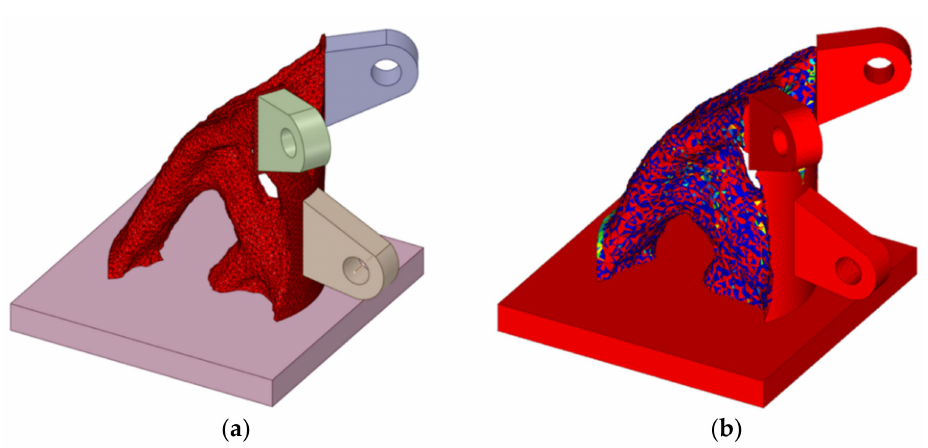
Figure 8. Topology-optimized joint: ( a ) topology-optimized joint by ANSYS; ( b ) topology-optimized joint by